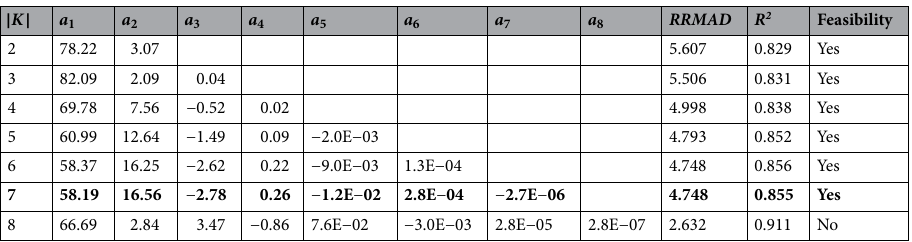
Table 4. Amount of coefficient, RRMAD, and R-squared for agri-food production. Significant values are in bold.